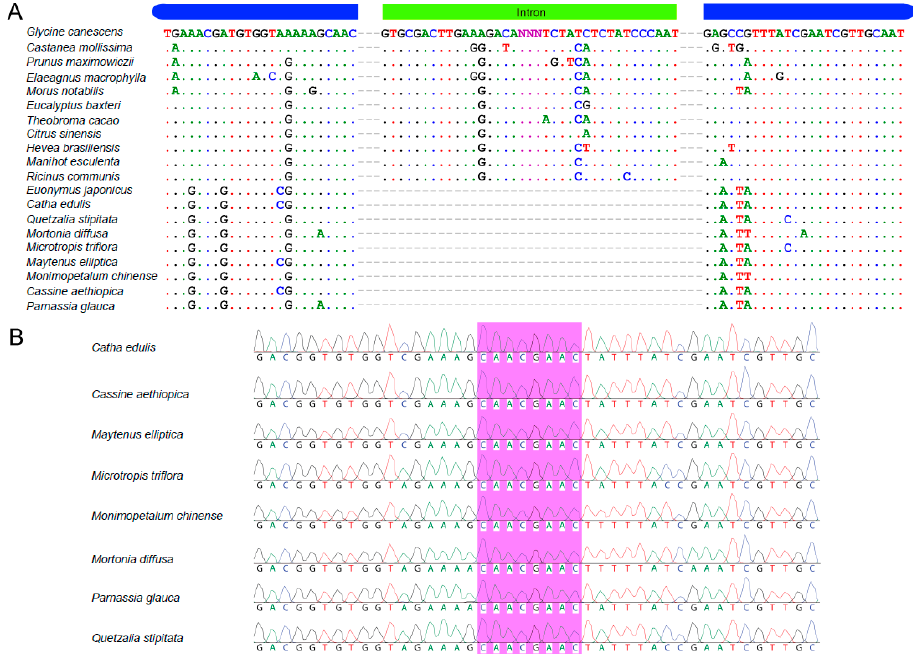
Figure 3. The sequence variation for rps16 gene with and without intron: ( A ) The structural components of rps16 gene in 20 species. All Species outside of Celastraceae family contained the rps16 intron. ( B ) The purple area in all eight species from different genera of the Celastraceae family showed the connection of two exons indicating the lost intron.